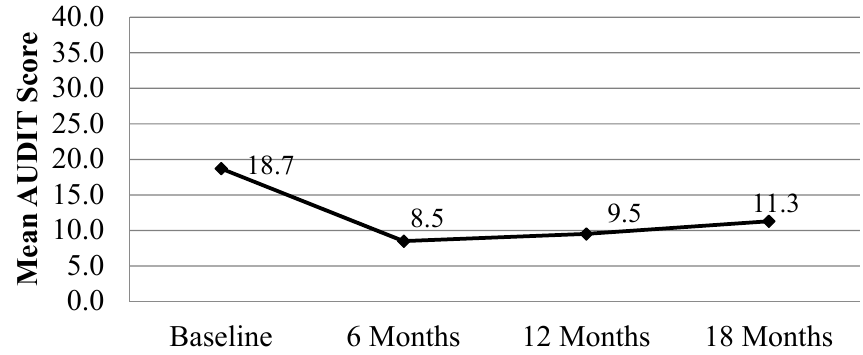
Figure 2. AUDIT score at baseline, 6, 12, and 18 month follow-up for women with data for all four time points. Repeated measures analysis, within-Ss effect, time: F = 23.323, p = 0.000; Pairwise comparisons (Bonferroni): Baseline vs. 6 month follow-up: p = 0.000; Baseline vs. 12 month follow-up: p = 0.000; Baseline vs. 18 month follow-up: p = 0.000.